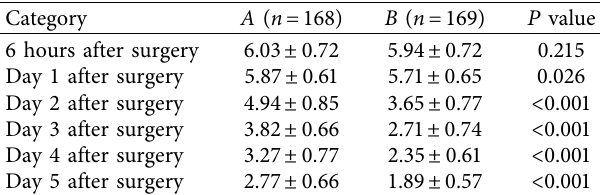
Table 5: Comparison of postoperative pain